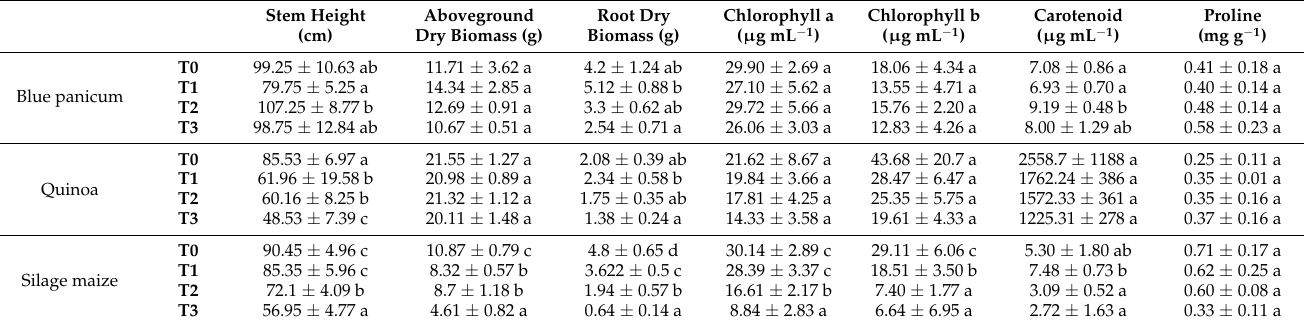
Table 1. Mean of stem height, aboveground and root dry biomass, chlorophyll a, chlorophyll b, carotenoid, and proline content of blue panicum, quinoa and silage maize by tested treatments. The irrigation water treatments. Lower-case (a, b, c, d) show differences between treatments within each measured parameter for each plant species; Data with different lowercase are significantly